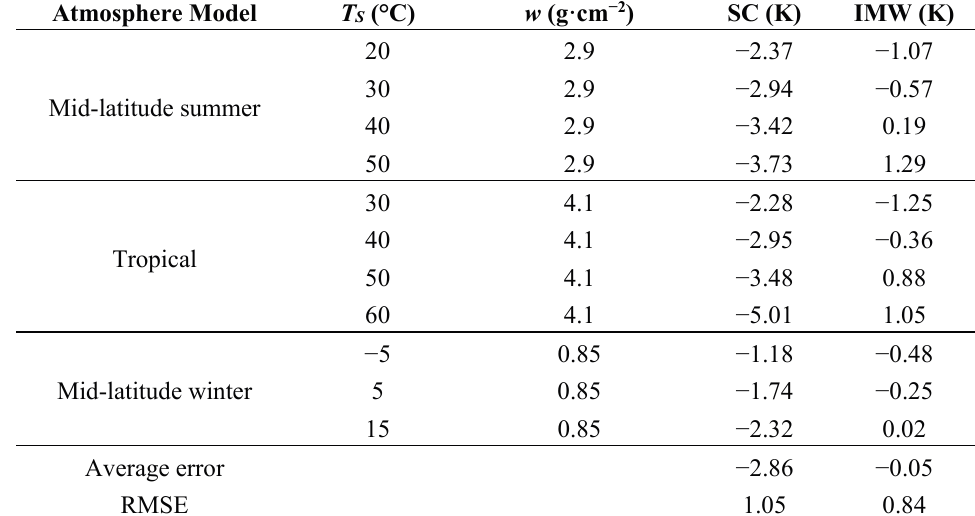
Table 11. Comparing LST retrieval errors of the IMW and single-channel (SC) algorithms for various